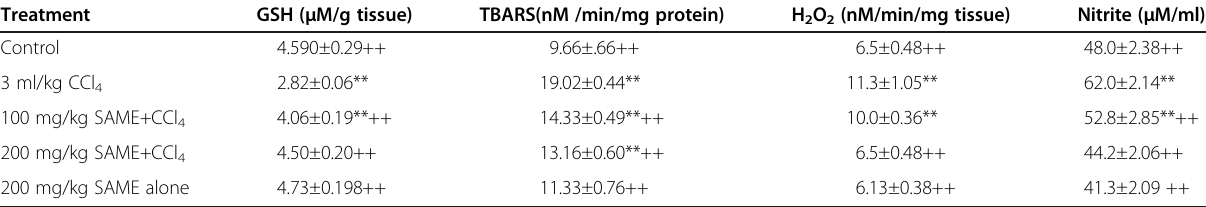
Table 4 Effect of SAME on thyroid GSH, TBARS, H 2 O 2 , nitrite